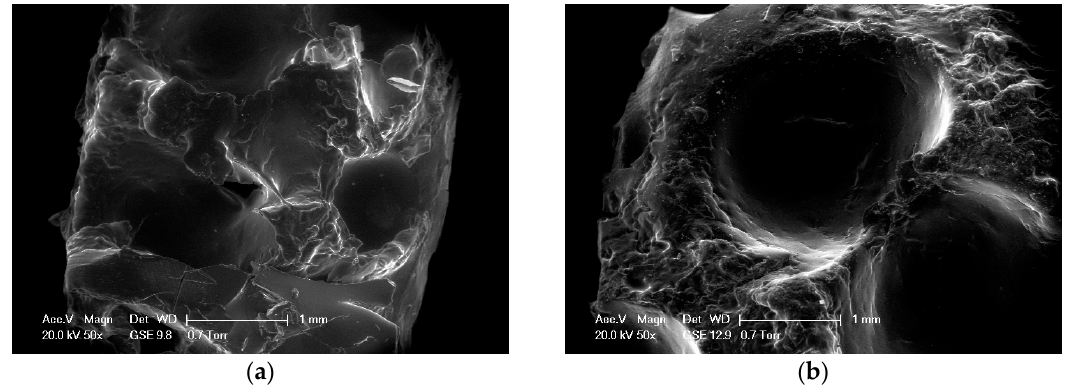
Figure 5. Apparent morphologies of two kinds of asphalts (R and T) under combination E: ( a ) Asphalt R; and ( b ) Asphalt T.